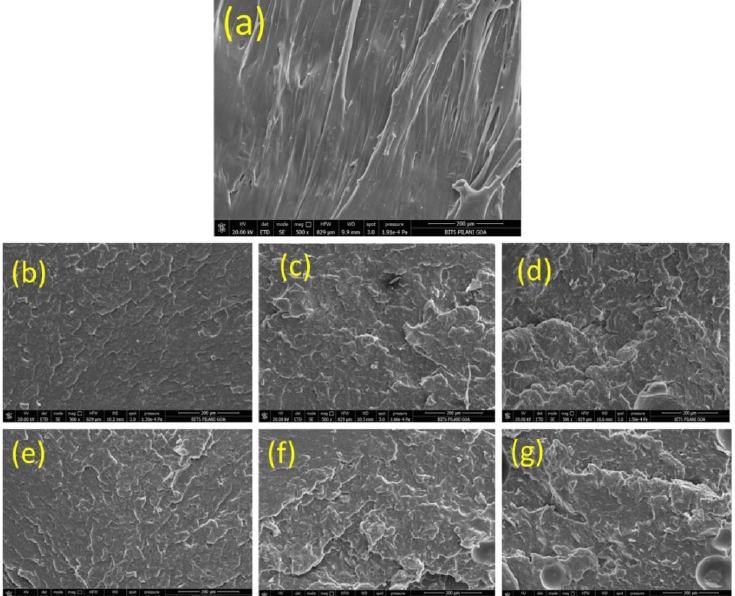
Figure 7. Impact fracture surface morphology of ( a ) virgin PP, ( b – d ) PP-H5 and ( e – g ) PP-H15 nanocomposites containing 1, 2 and 3 wt.% GNPs at ×500 magnification.